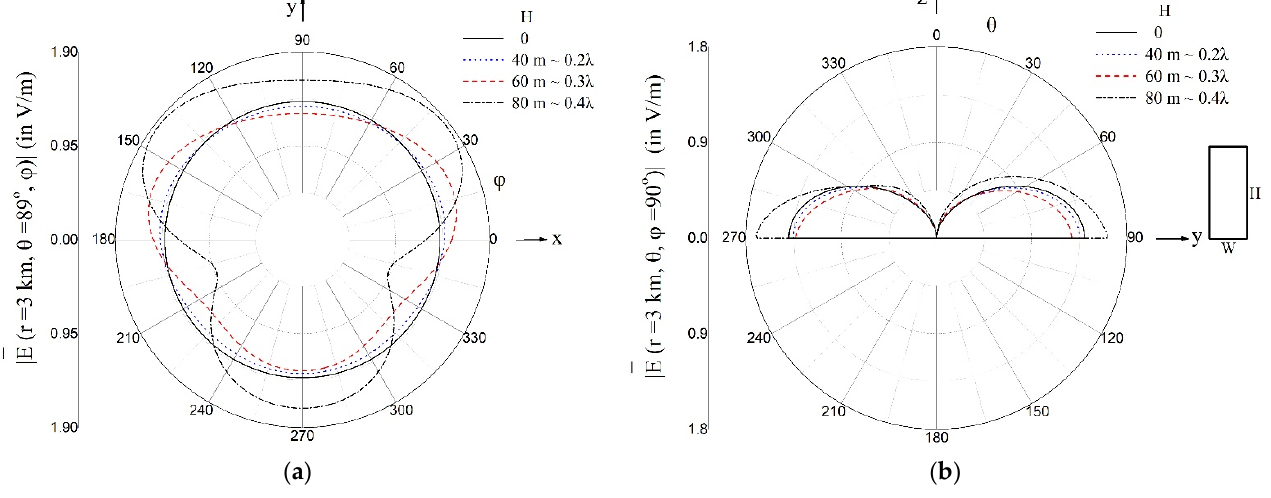
Figure 4. Radiation patterns of the monopole in free space (black, solid curve) and in the presence of a building with 𝐿 = 10 m ≈ 0.05𝜆 and 𝑊 = 10 m ≈ 0.05𝜆 . Three different heights H are considered (dashed and dotted curves, as indicated in the upper right corner). The distance between the antenna and the building is 𝑅 = 100 m ≈ 0.5𝜆 . ( a ) 𝜑 -plane and ( b ) 𝜃 -plane.